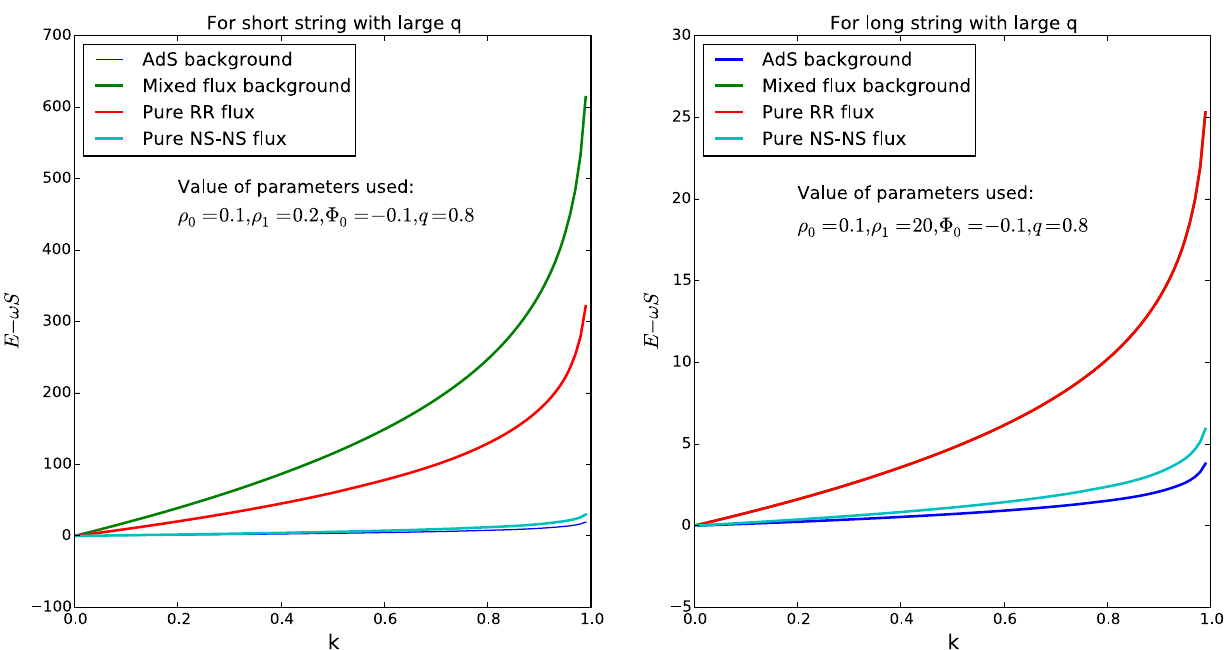
Fig. 7 For short string limit the spin-energy relation of pure RR flux background follows quite different curve than the mixed-flux back- ground for high value of NS-NS flux ( q = 0 . 8). But, for long string